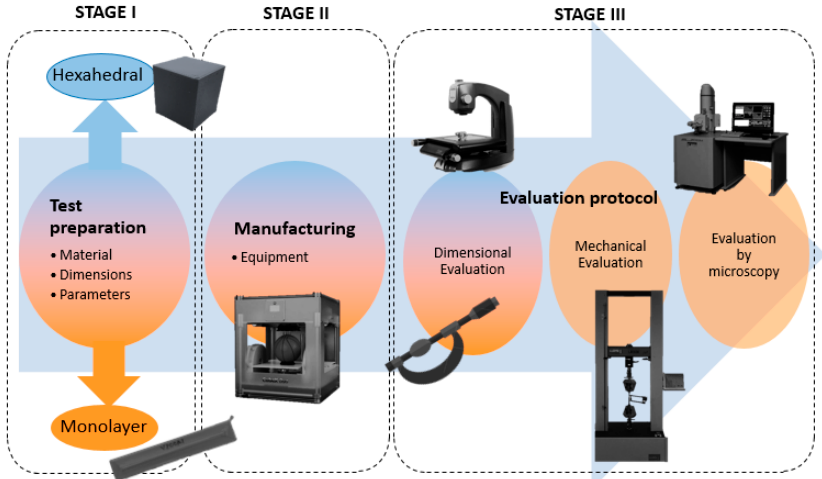
Figure 1. Flow chart of the experimental Procedure.